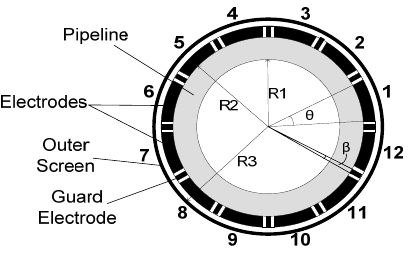
Figure 2. ECT sensor